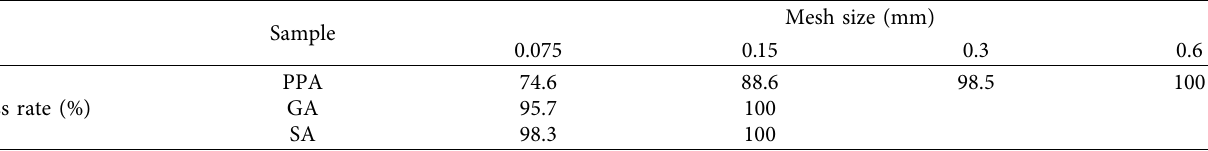
Figure 1: Raw material pictures: (a) SA; (b) PPA; (c) GA. Table 2: Granular composition of three fine powders of OSWA residue.